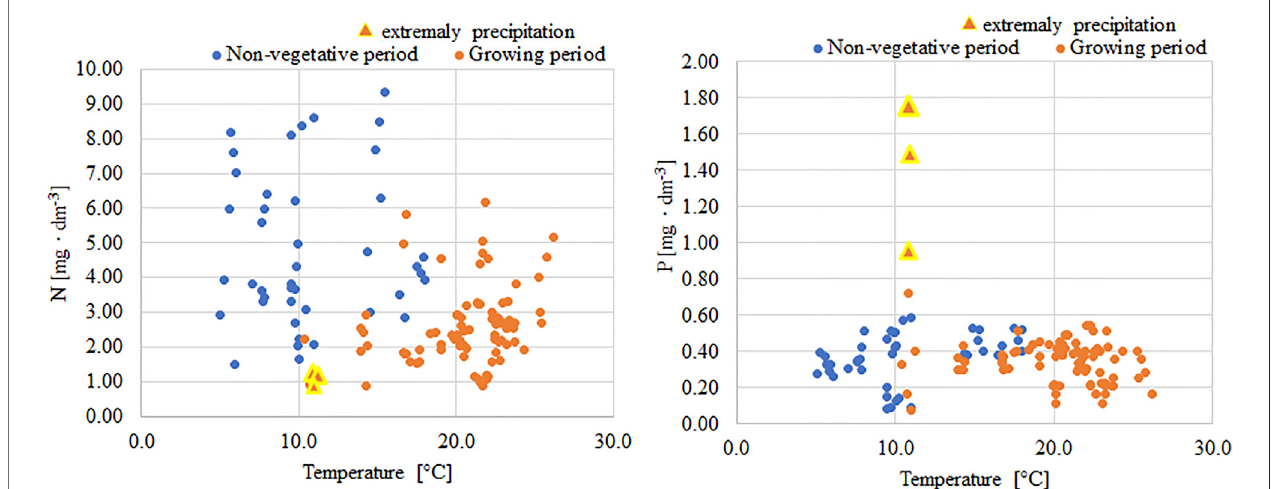
FIGURE 7 | Total nitrogen and phosphorous concentration vs. air temperature during hydrological years 2016 – 2018.